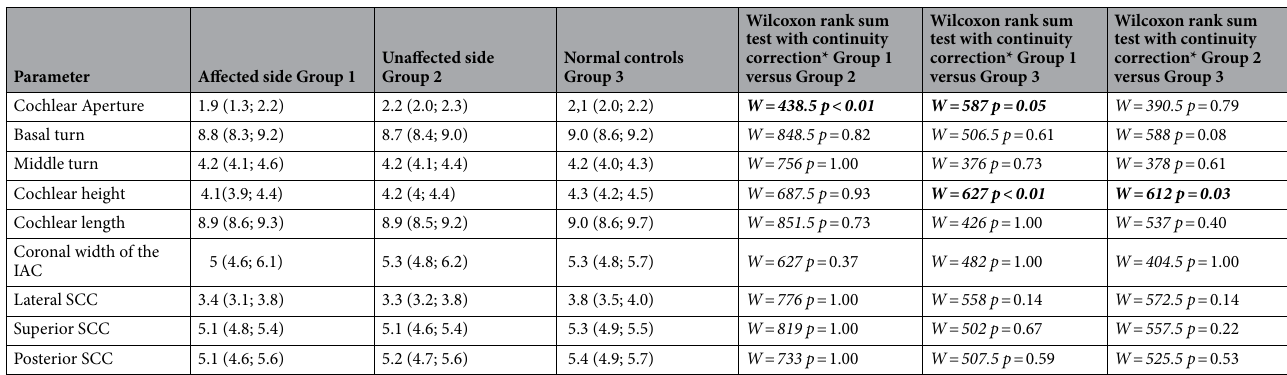
Table 3. Median and quartiles (q1; q3) of the measurements acquired from computed tomography and group differences (bold, p < 0,05). SCC semicircular canals, IAC inner auditory canal. *The p values were corrected for the multiple comparisons with the Bonferroni correction